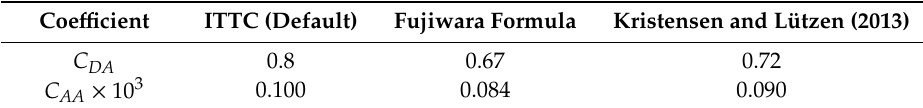
Figure 10. Schematic profile above the waterline for calculating the Fujiwara formula. Table 9. Comparison of C DA through di ff erent calculating methods. Table 7. Parameters for calculating the Fujiwara formula.